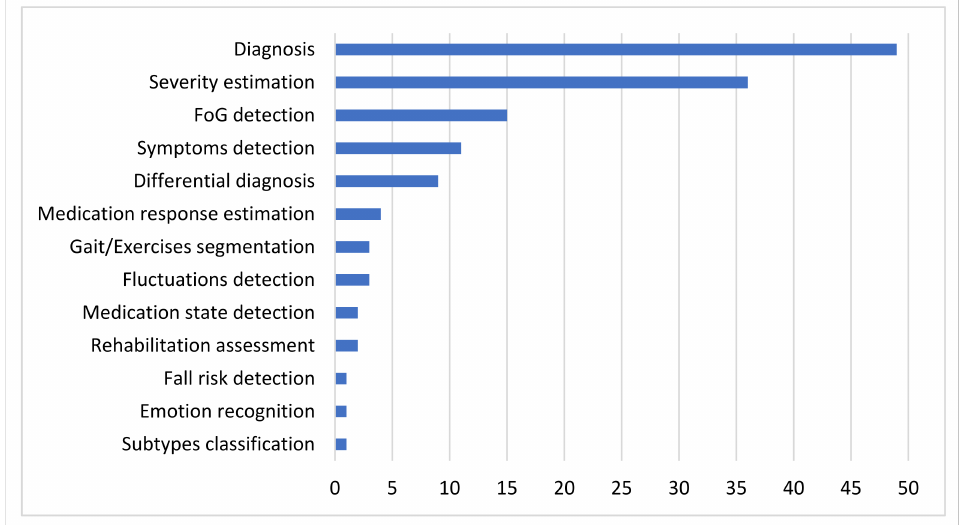
Figure 9. Frequency of PD-related problems studied independently of type of input data